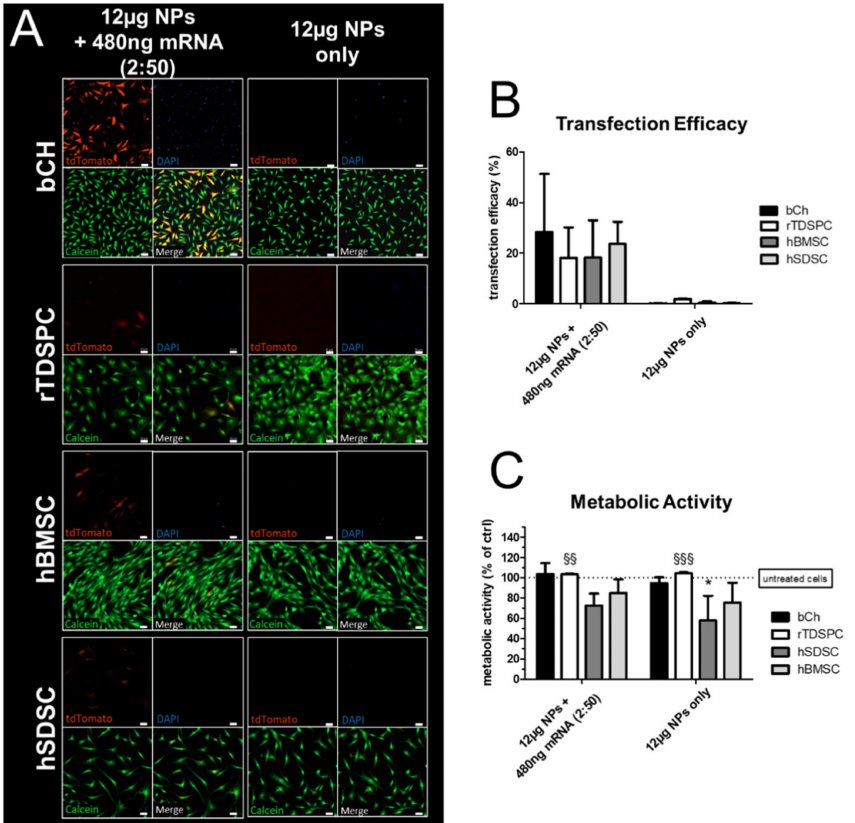
Figure 3. Cell viability and transfection efficiency of different primary cells treated with tdTomato mRNA-complexed nanoparticles (NPs). ( A ) Fluorescence images of bCH, rTDSPC, hBMSC, hSDSC treated with 12 µ g NPs complexed with 480 ng tdTomato mRNA (2:50 w / w ratio mRNA:NPs). tdTomato-positive cells (red), dead cells stained with DAPI (blue), and live cells stained with Calcein (green). Scale bar = 50 µ m. ( B ) Transfection efficiency analyzed with flow cytometry shown as % tdTomato-positive cells of the entire cell population ( n = 3; ANOVA and Tukey’s Multiple Comparison test). ( C ) Metabolic activity is shown as % metabolic activity relative to control cells treated with HEPES buffer ( n = 3; ANOVA and Dunnet’s Multiple Comparison test using untreated cells as control). § used to indicate significance for rTDSPC, * for hSDSC; * p < 0.05, §§ p < 0.01, §§§ p <